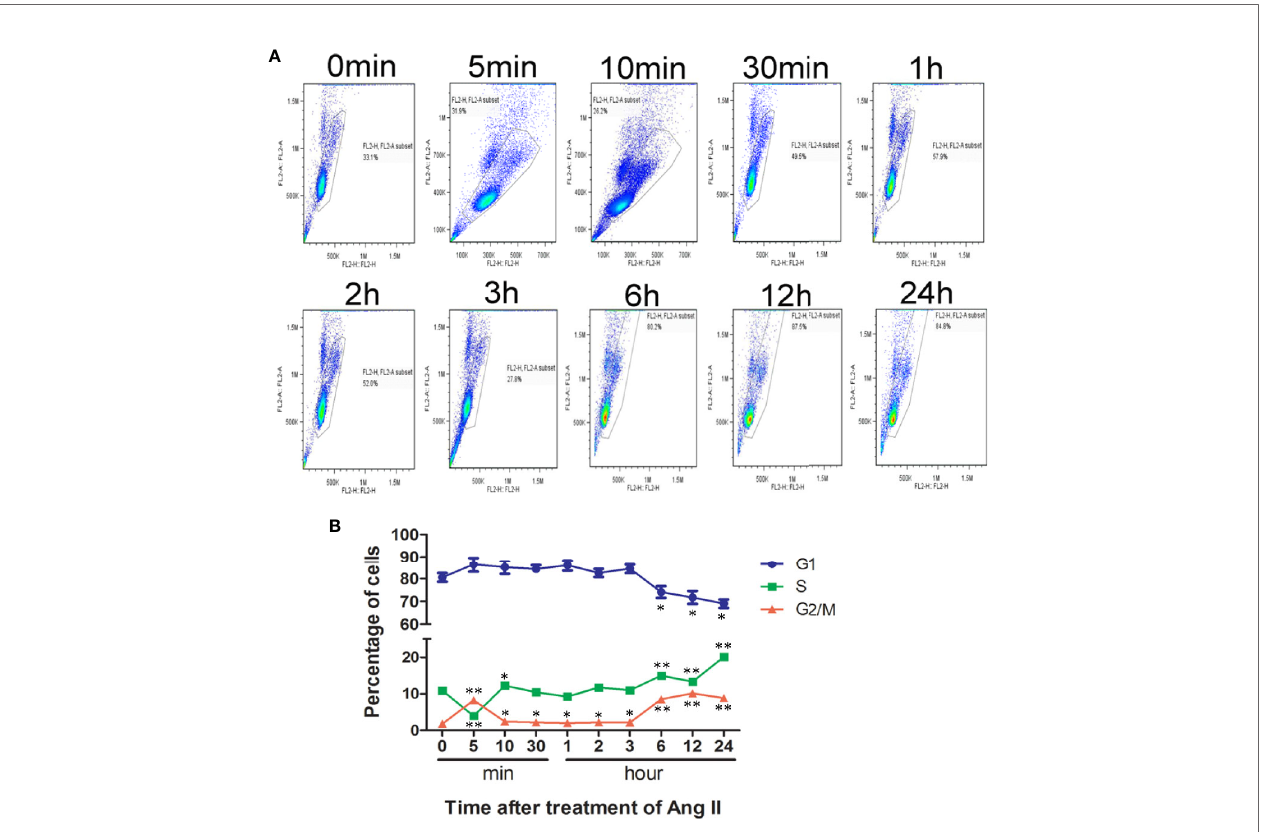
FIGURE 1 | Cell cycle analysis after stimulation with Ang II. Neonatal rat ventricular myocytes (NRVMs) were treated with Ang II (1.0 µmol/L) for the scheduled times (0, 5, 10, and 30 min, and 1, 2, 3, 6, 12, and 24 h). (A) Flow cytometry analysis of cardiomyocytes stained with propidium iodide (PI). All experiments were conducted in duplicate and repeated three times (n = 3). (B) Data are presented as the mean ± SEM, *P < 0.05, **P < 0.01 compared with the controls (0 min), (one-way